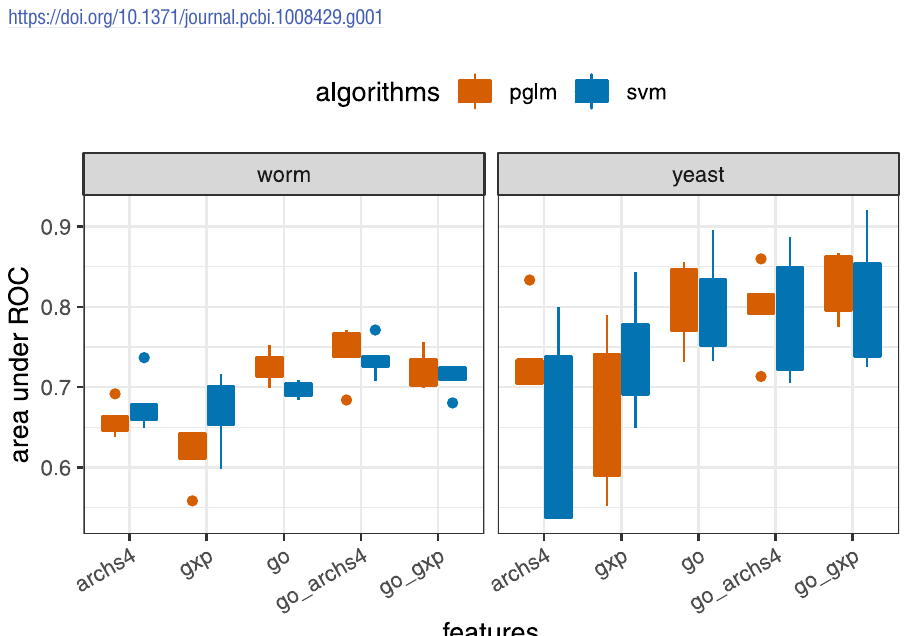
Fig 2. Combining gene expression (archs4, gxp) with gene ontology (GO) features yields improved classification performance in terms of AUC. pglm: elastic net penalized logistic regression, svm: support vector machine with radial basis function. An AUC value of 1 indicates perfect classification, whereas an AUC of 0.5 signifies performance no better than random.